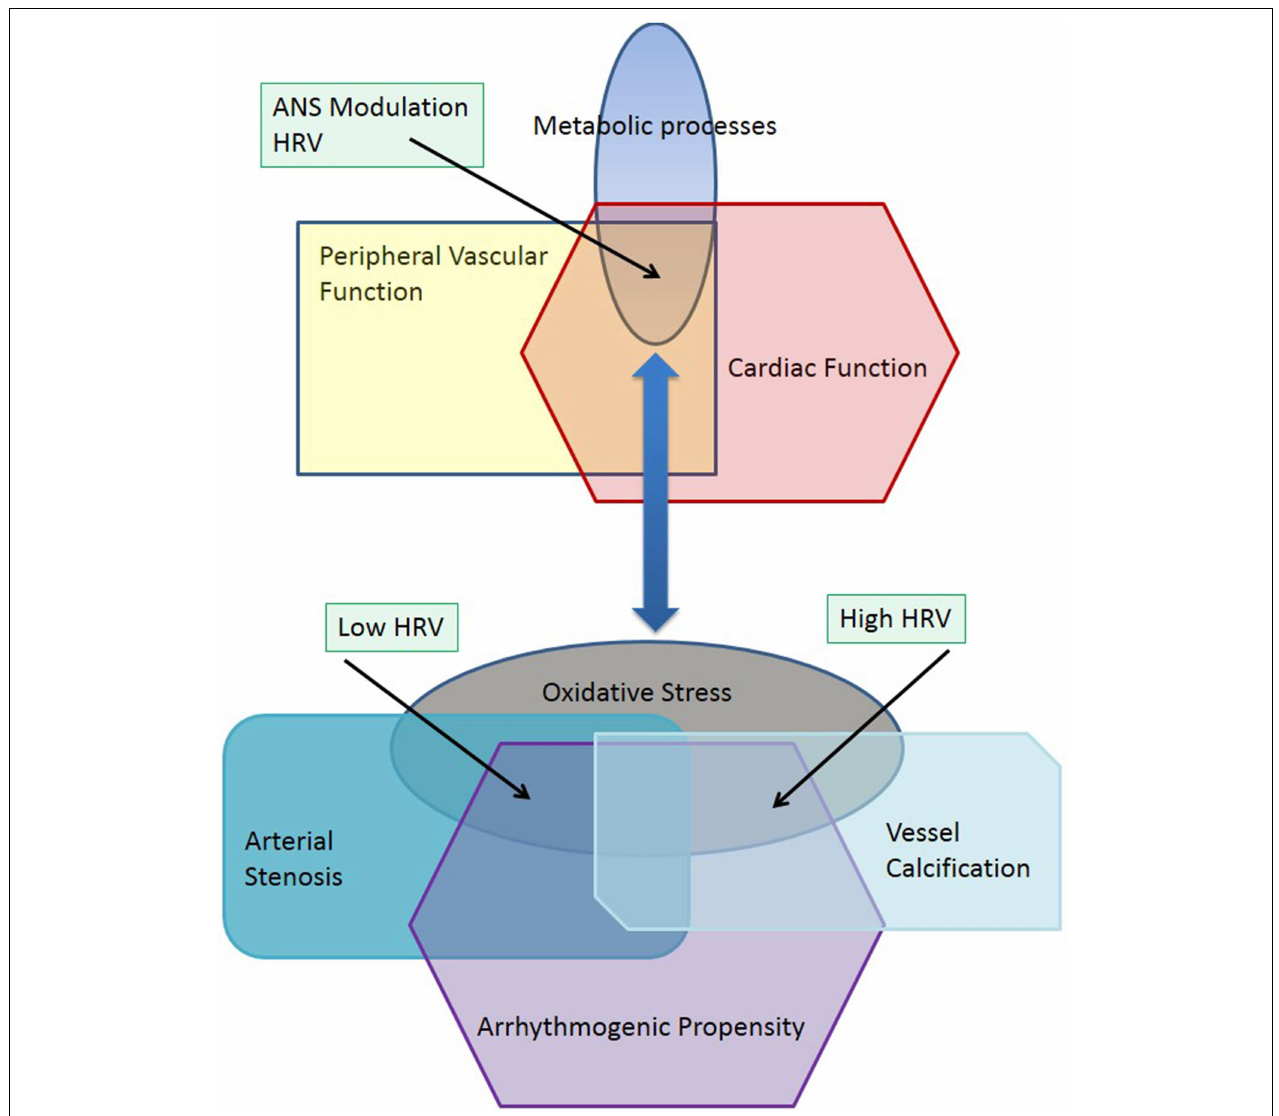
FIGURE 1 | Progression and divergence of peripheral vascular disease and